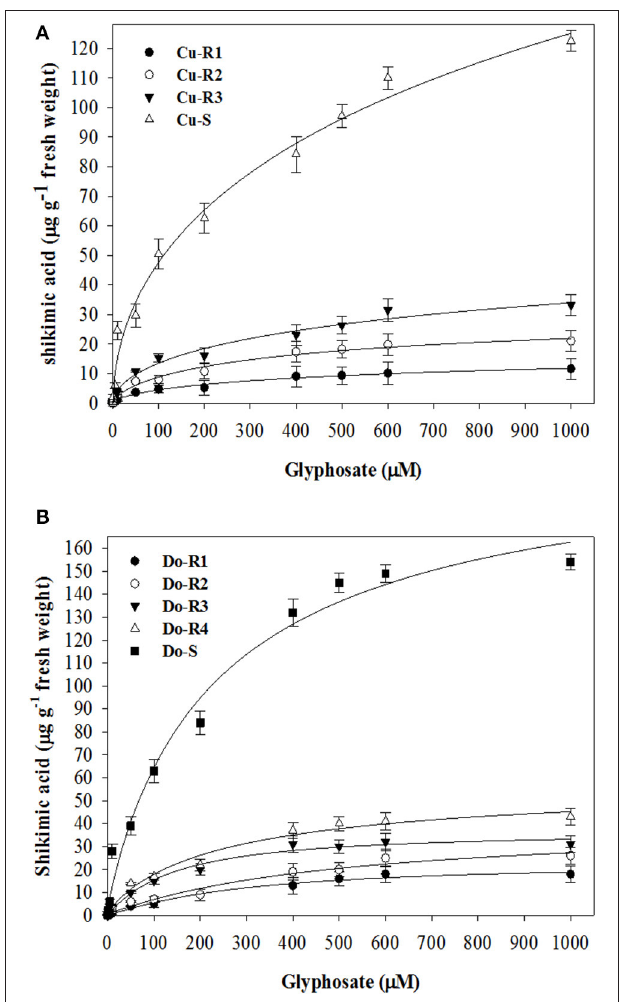
FIGURE 4 | EPSPS enzyme activity expressed as percentage of the untreated control in leaf extracts of plants from Cuba (A) and Dominican Republic (B) accessions of P. hysterophorus . Symbols denoted mean ( n = 3) ± standard errors of the